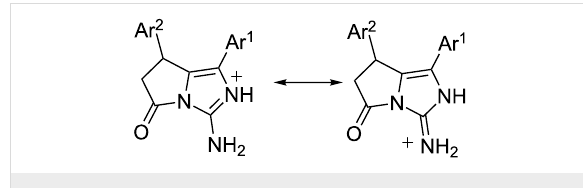
Figure 4: Molecular structure of 3-(2-amino-4-phenyl-1 H -imidazol-5- yl)-3-( p -tolyl)propanoic acid 11b according to X-ray diffraction data. Thermal ellipsoids of atoms are shown at 50% probability level.